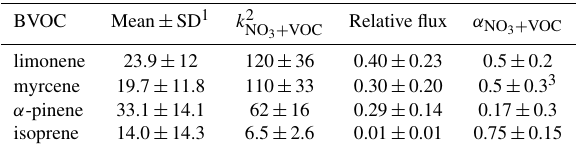
Table 3. Mean night-time BVOC mixing ratios during